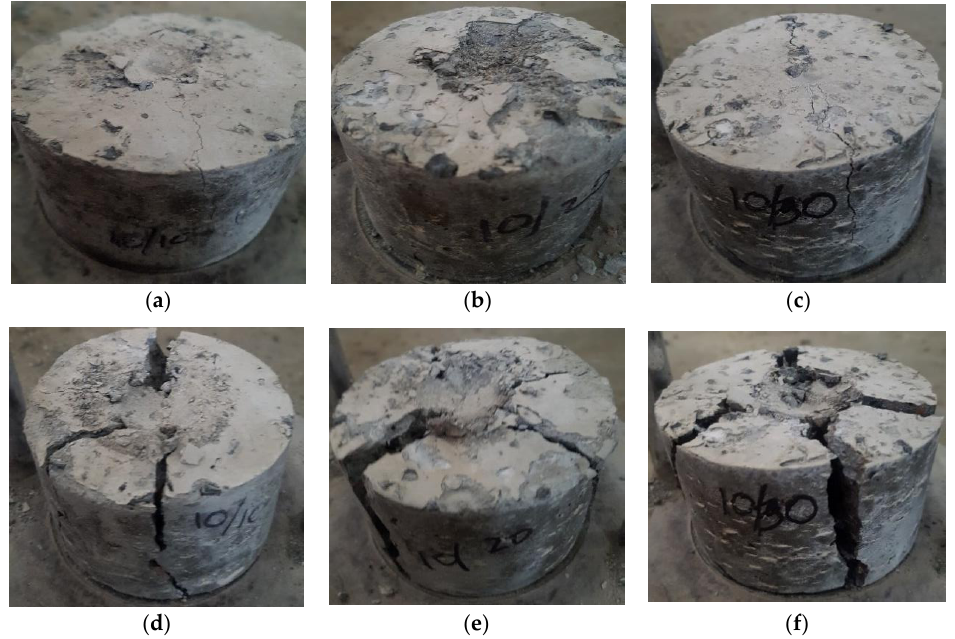
Figure 19. Cracking pattern for specimens with various dosages of R10 rubber: ( a ) initial crack for 10% R10, ( b ) initial crack for 20% R10, ( c ) initial crack for 30% R10, ( d ) final crack for 10% R10, ( e ) final crack for 20% R10, ( f ) final crack for 30% R10.